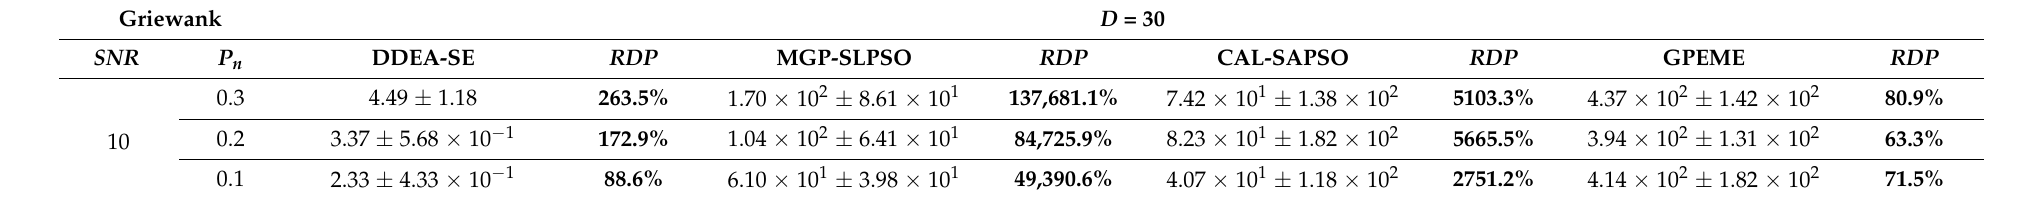
Table A8. Experimental results (with standard deviation) and RDP of DDEAs on 30-dimensional Griewank problems.